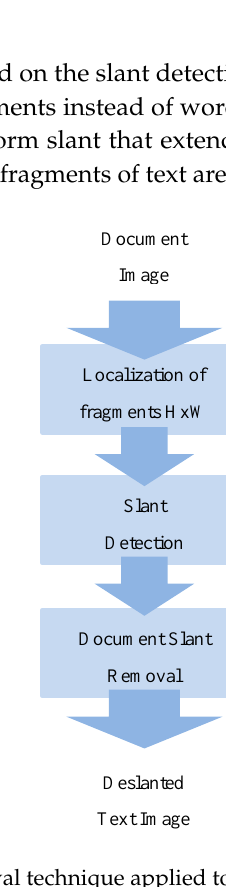
Figure 4. The proposed slant removal technique applied to fragments of text corrects the entire page without segmentation.